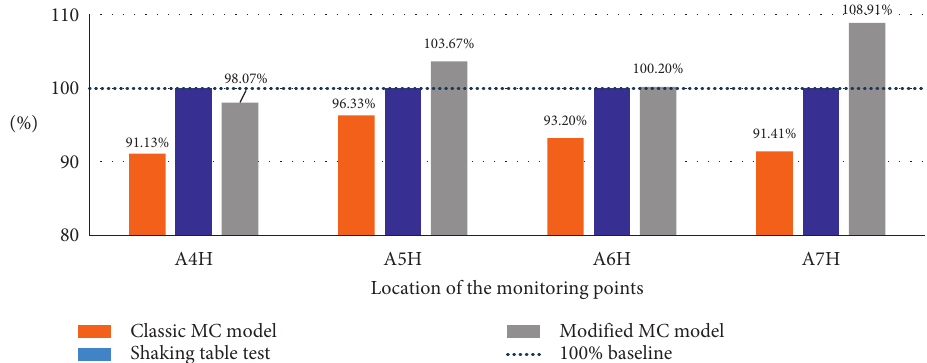
Figure 20: Histogram of the maximum accelerations at all monitoring points for the different yield criterion models.